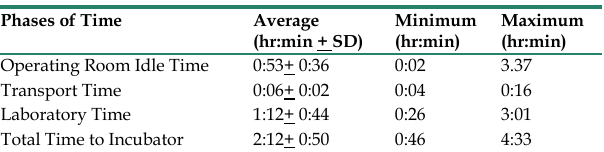
Table 1. Results Comparing Time Spent in Phases